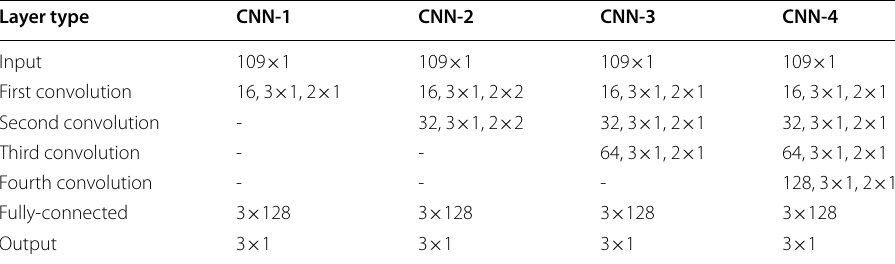
Table 3 CNN architecture with its layers and